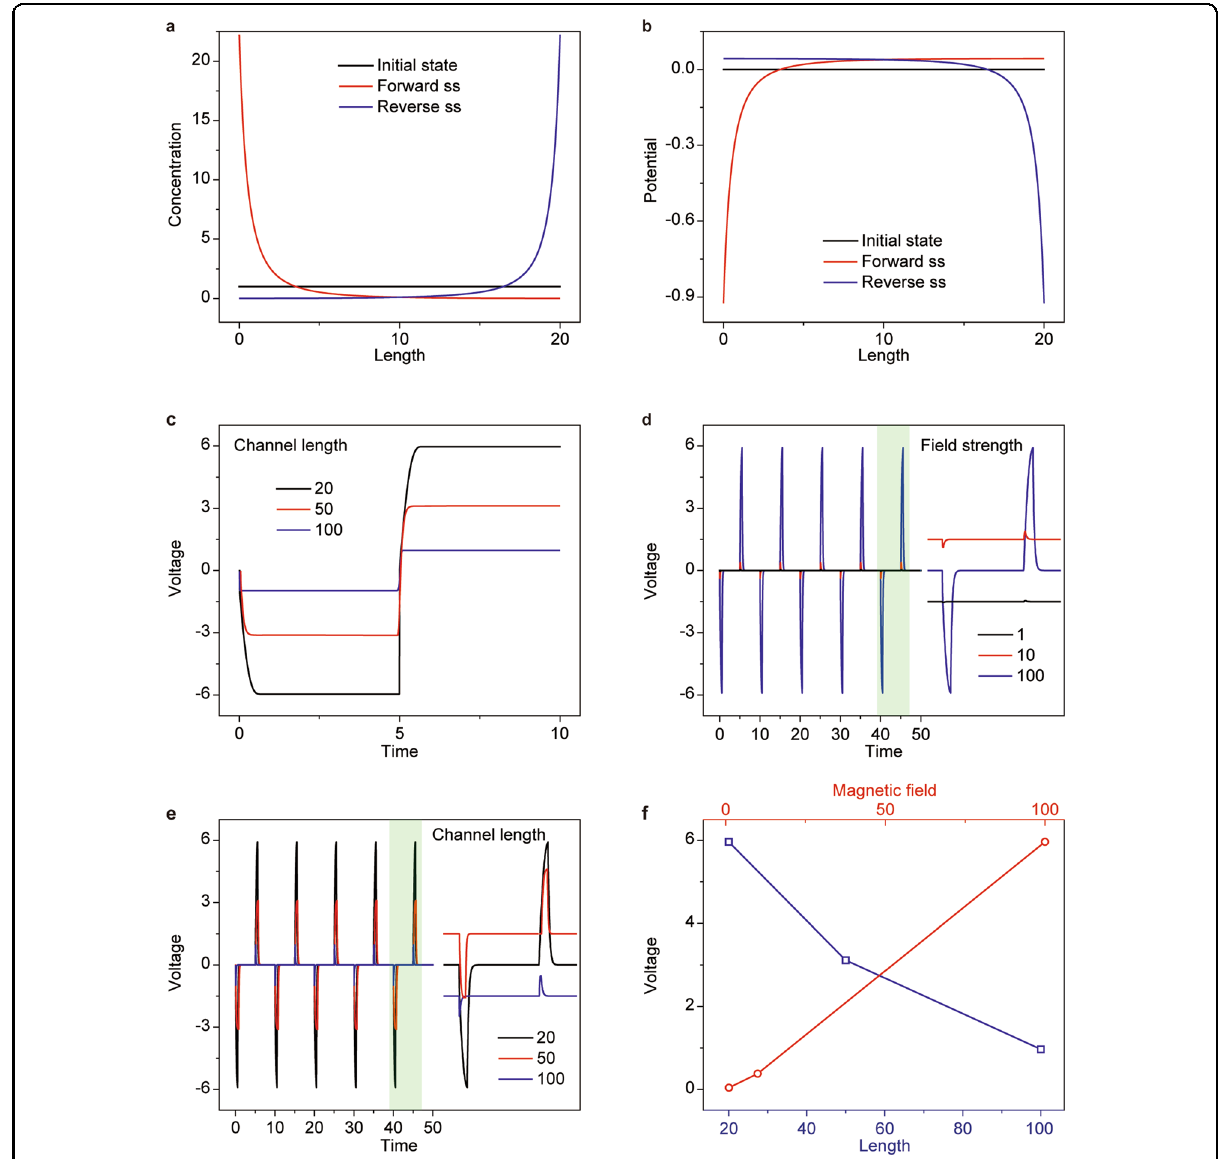
Fig. 3 Simulation of the mag-TMA AuNP nanogenerator. a , b Distributions of the DyCl 4- counterions ( a ) and potentials ( b ) at the initial state, forward steady state, and reverse steady state. c Time-dependent voltage within the mag-TMA AuNP fi lm. d , e Time-dependent open-circuit voltages as a function of the strength of the magnetic fi eld ( d ) and channel length between two electrodes ( e ). The light-green highlighted regions are magni fi ed and plotted on the right. For the sake of clarity, the red/black curves in ( d ) and red/blue curves in ( e ) are arti fi cially moved upward/ downward by 1.5. f The open-circuit voltage amplitudes as a function of channel length (blue curve, bottom x-axis) and magnetic fi eld strength (red curve, top x-axis). Three magnetic fi elds (1, 10, and 100) and channel lengths (20, 50, and 100) are used for simulation. The magnetic fi eld in ( a ) to ( c ) and ( e ) is 100, and the channel length in ( d ) is